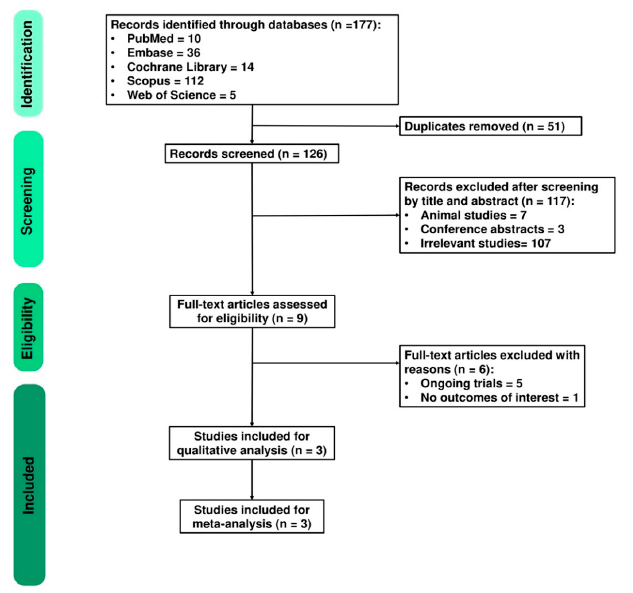
Figure 1. PRISMA flow diagram.